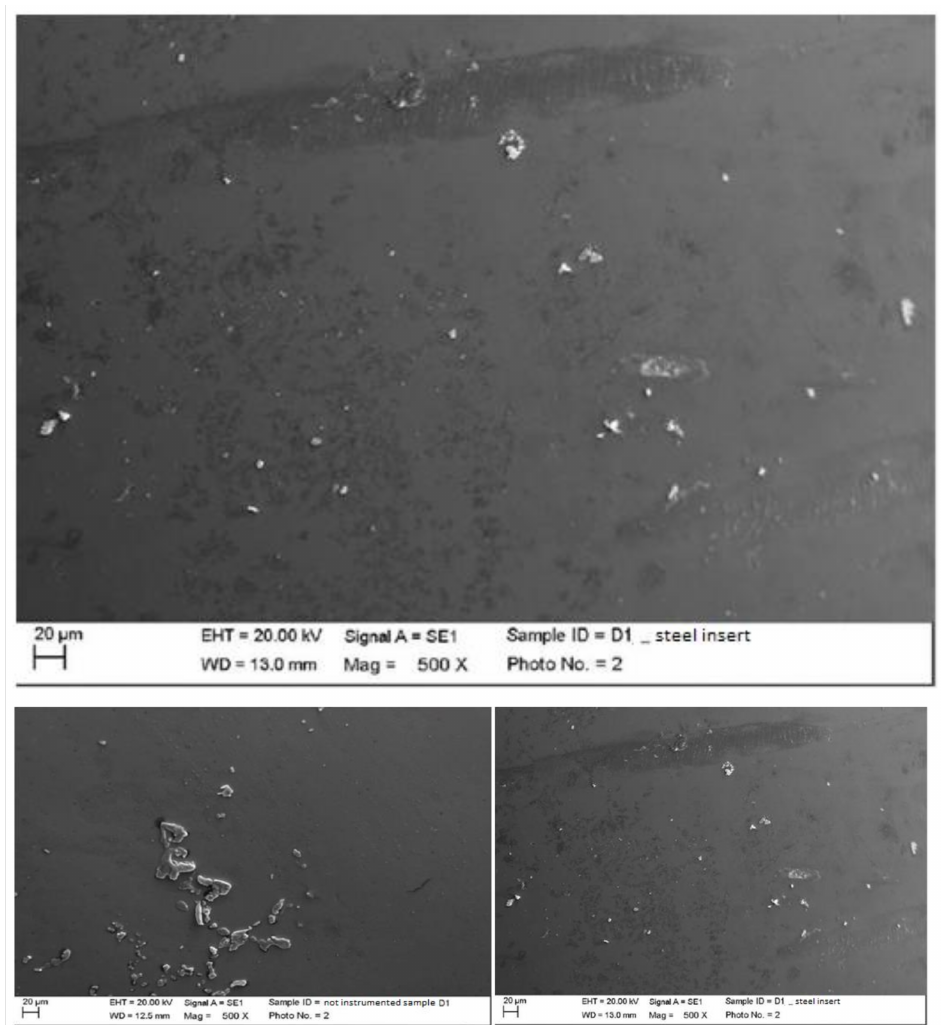
Figure 10. Instrumented disilicate sample D1 with steel insert (500 × ). Comparison before/after